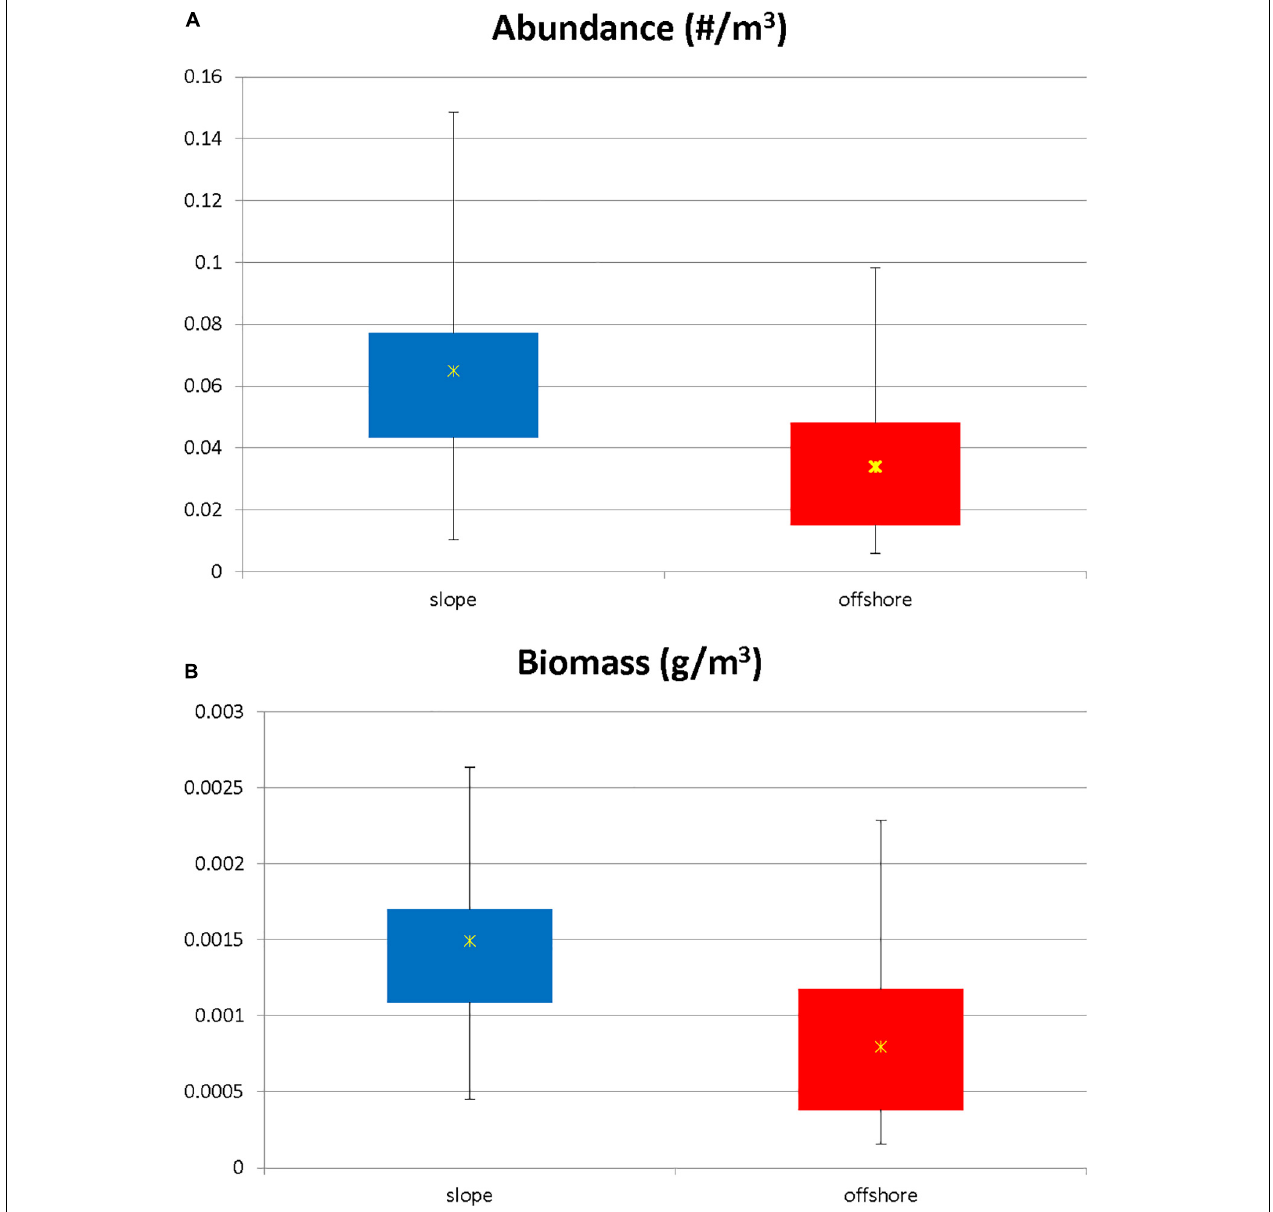
FIGURE 3 | (A) Standardized abundance (N m − 3 ) for slope vs. offshore euphausiid assemblage. Abundance was significantly higher in the slope stations (Kruskal Wallis, p = 0.005). Stars represent mean values. (B) Standardized biomass for slope vs. offshore euphausiid assemblage. Biomass was significantly higher in the slope stations (Kruskal Wallis, p = 0.0009). Stars represent mean